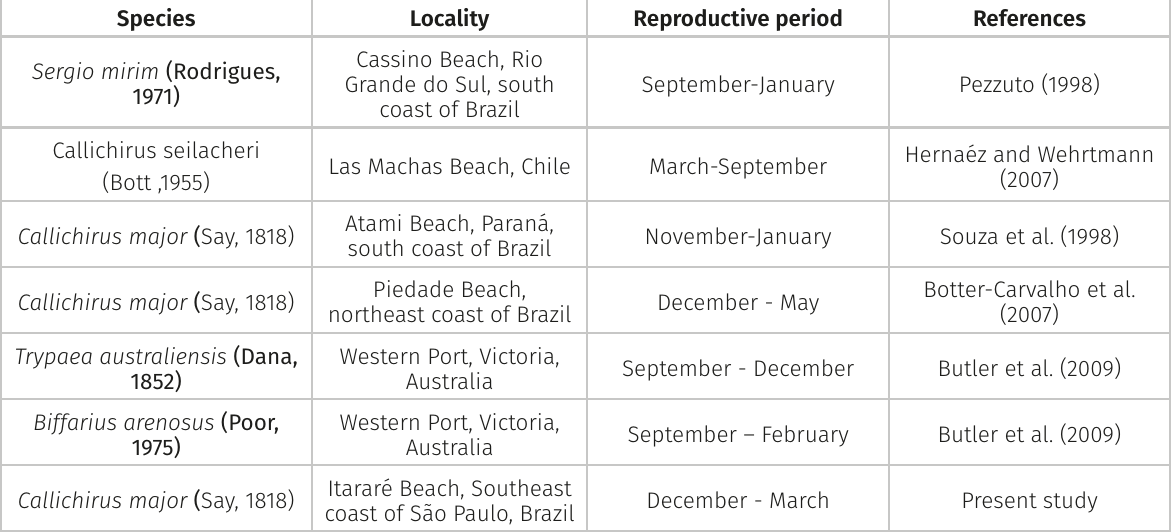
Table III. Reproductive periods of C. major and other callianassids in different localities.